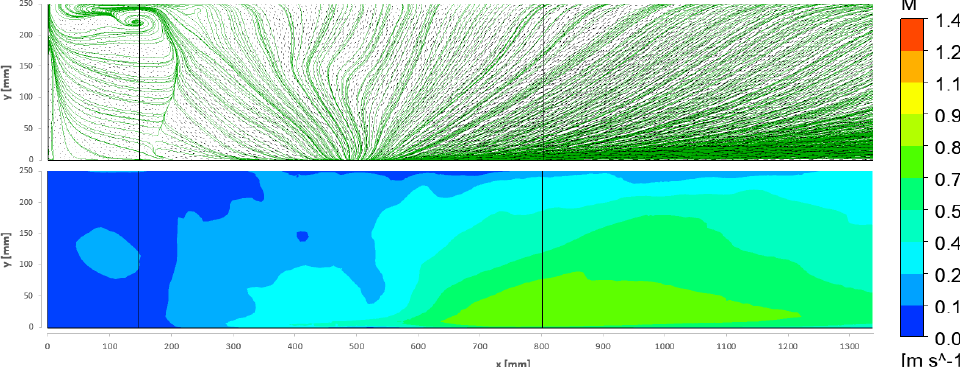
Figure 19. Finite volume method (SAS model), vector lines ( top ) and the magnitude of time-averaged 2D velocity ( bottom ) in vertical plane ( z = 141mm )